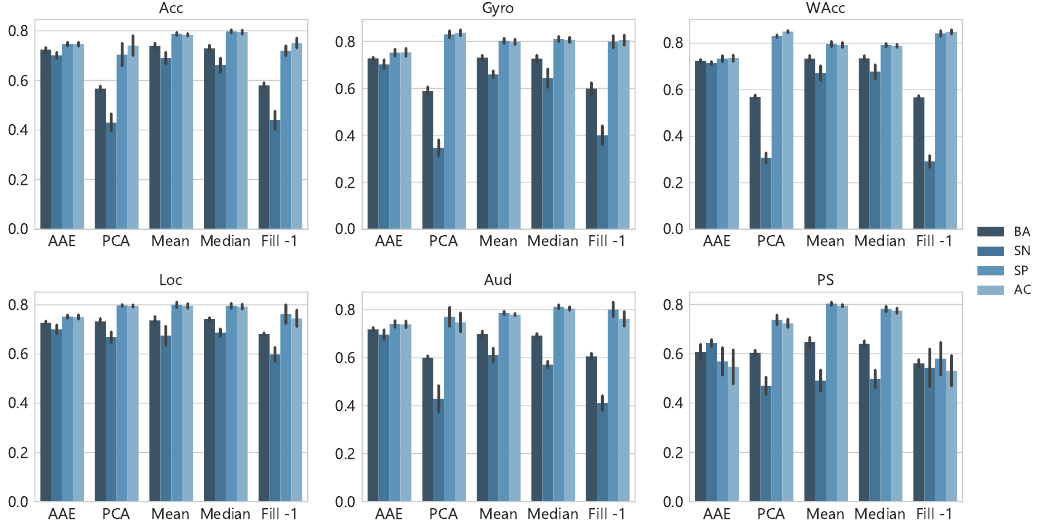
Figure 9. Average evaluation metrics for 51 contextual labels with 5-folds cross-validation. All the features from the corresponding modality are dropped and imputed with all the considered techniques.